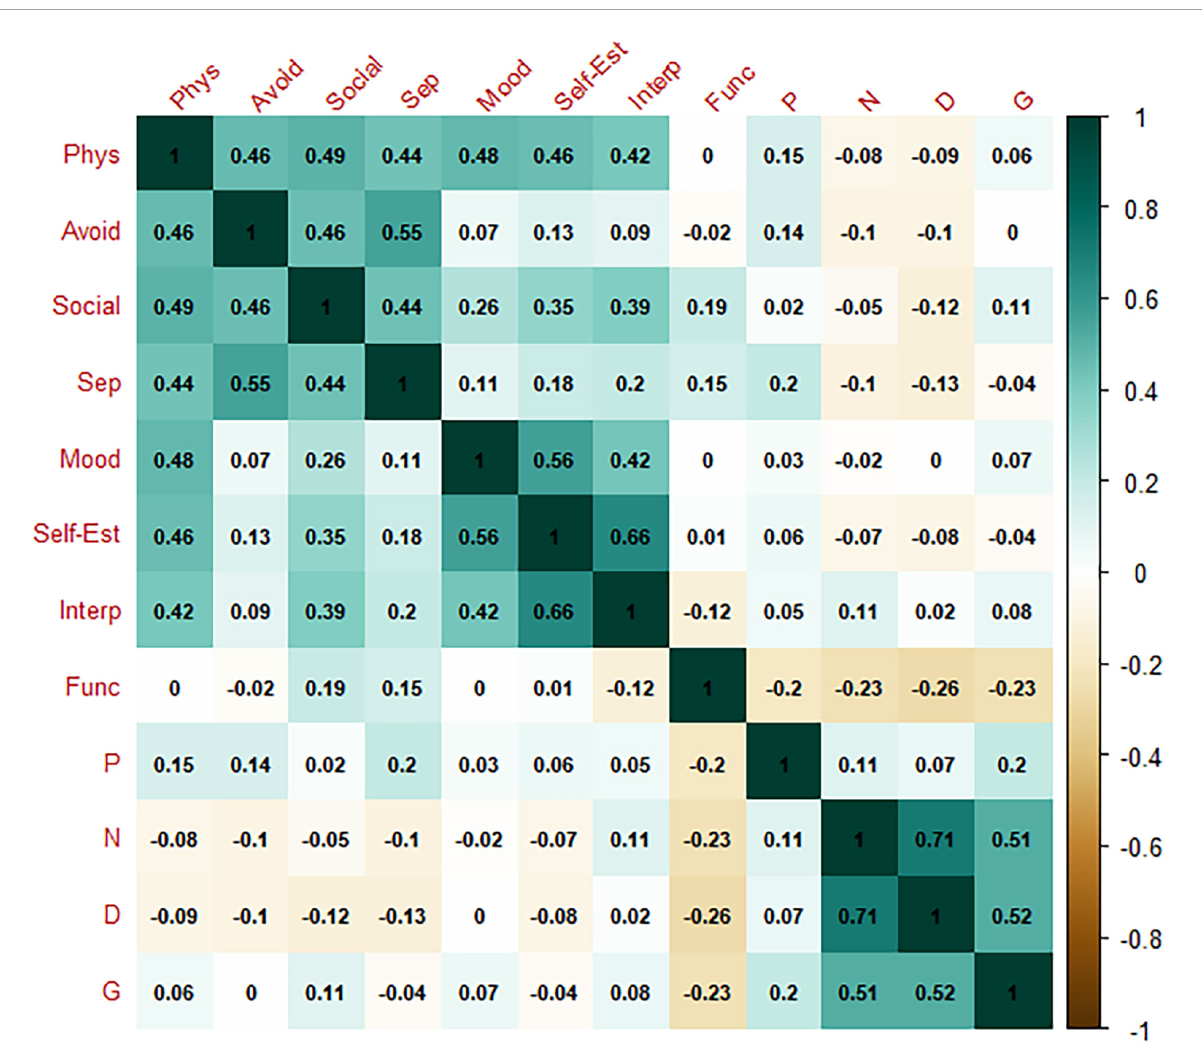
FIGURE2 Correlation matrix. Phys, physical symptoms; Avoid, harm avoidance; Social, social anxiety; Sep, separation anxiety; Mood, negative mood; Self-Est, negative self-esteem; Interp, interpersonal problems; Func, general functioning; P, psychotic symptoms; N, negative symptoms; D, disorganization symptoms; G, general